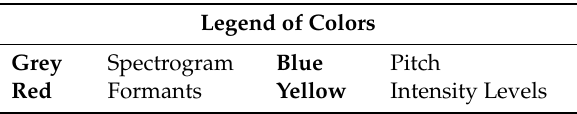
Table 2. Legend of the colors in the figures.